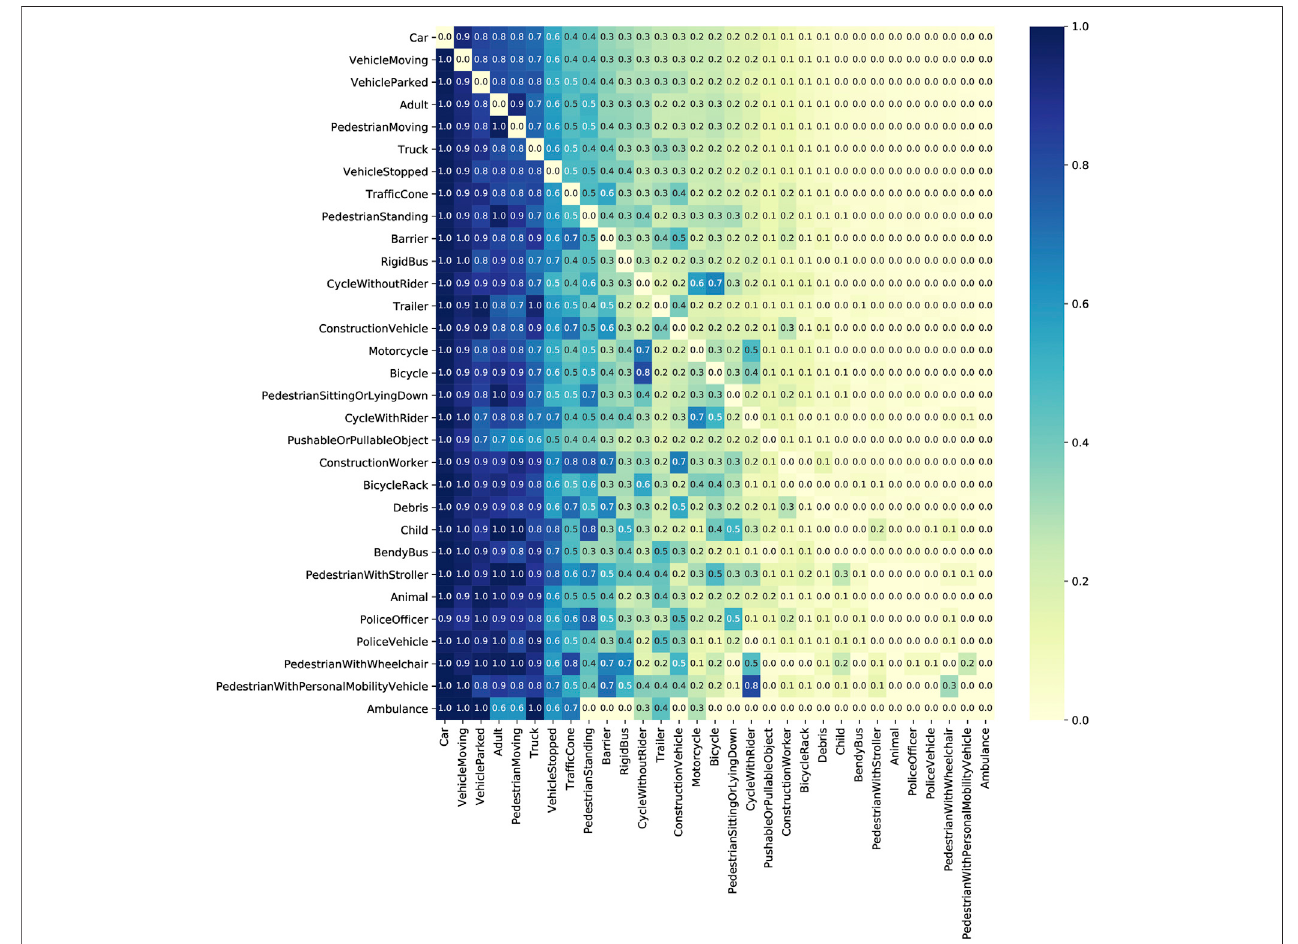
FIGURE4| Co-occurrenceofentitytypeswithinscenesinDSKG-N.EachcellvaluerepresentsthefrequencyofFramesinwhichtwoentitiesco-occur,normalized row-wise by the total frequency of Frames in which the row entity